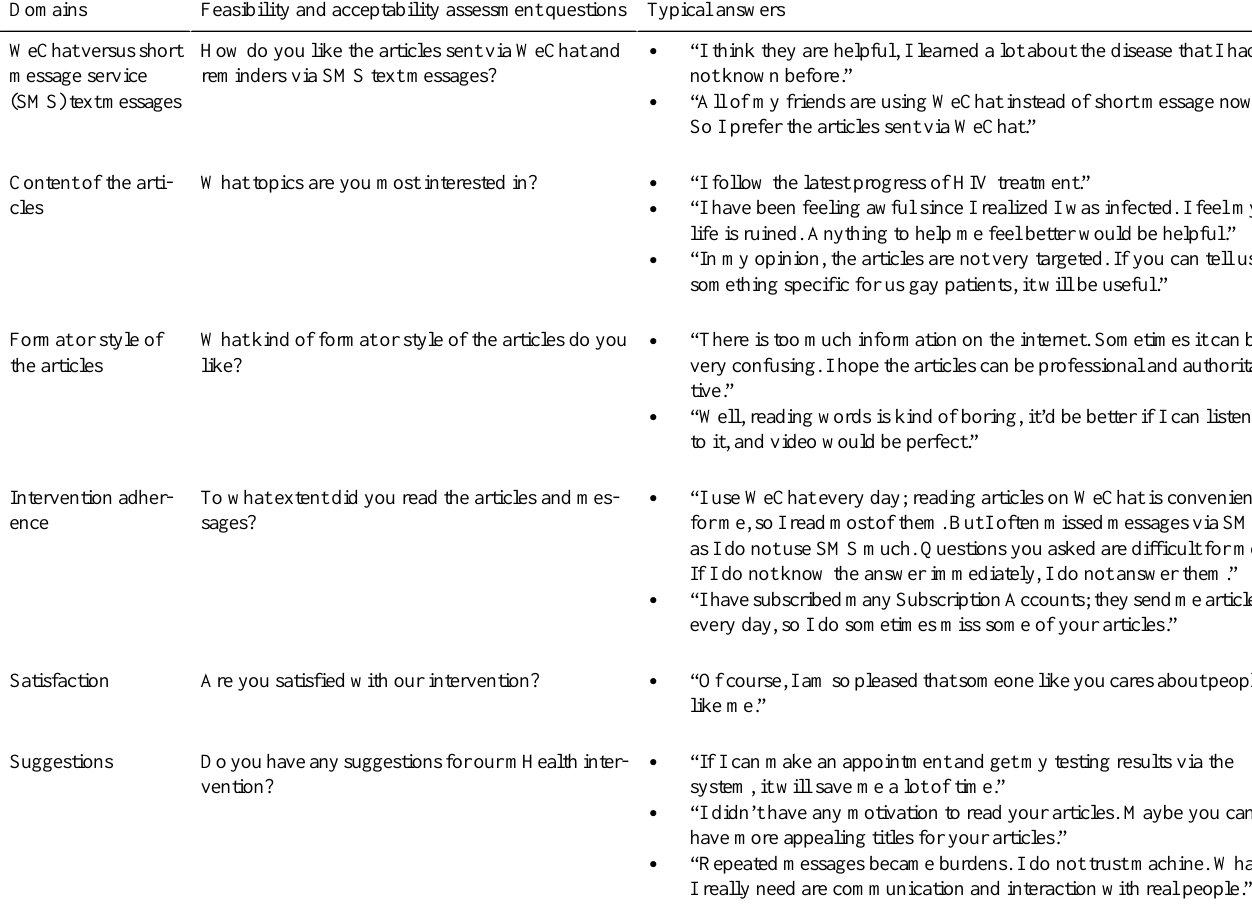
Table 3. Summary of the qualitative analysis on the feasibility and acceptability evaluation.